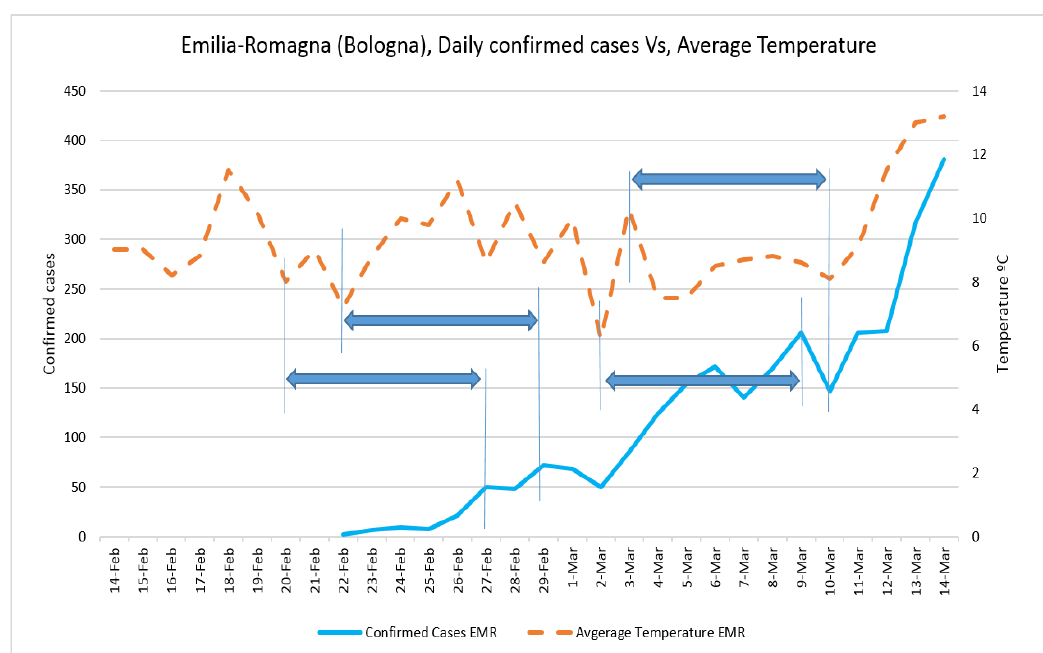
Figure 8. Daily confirmed cases of COVID-19 in Emilia-Romagna and average temperature.